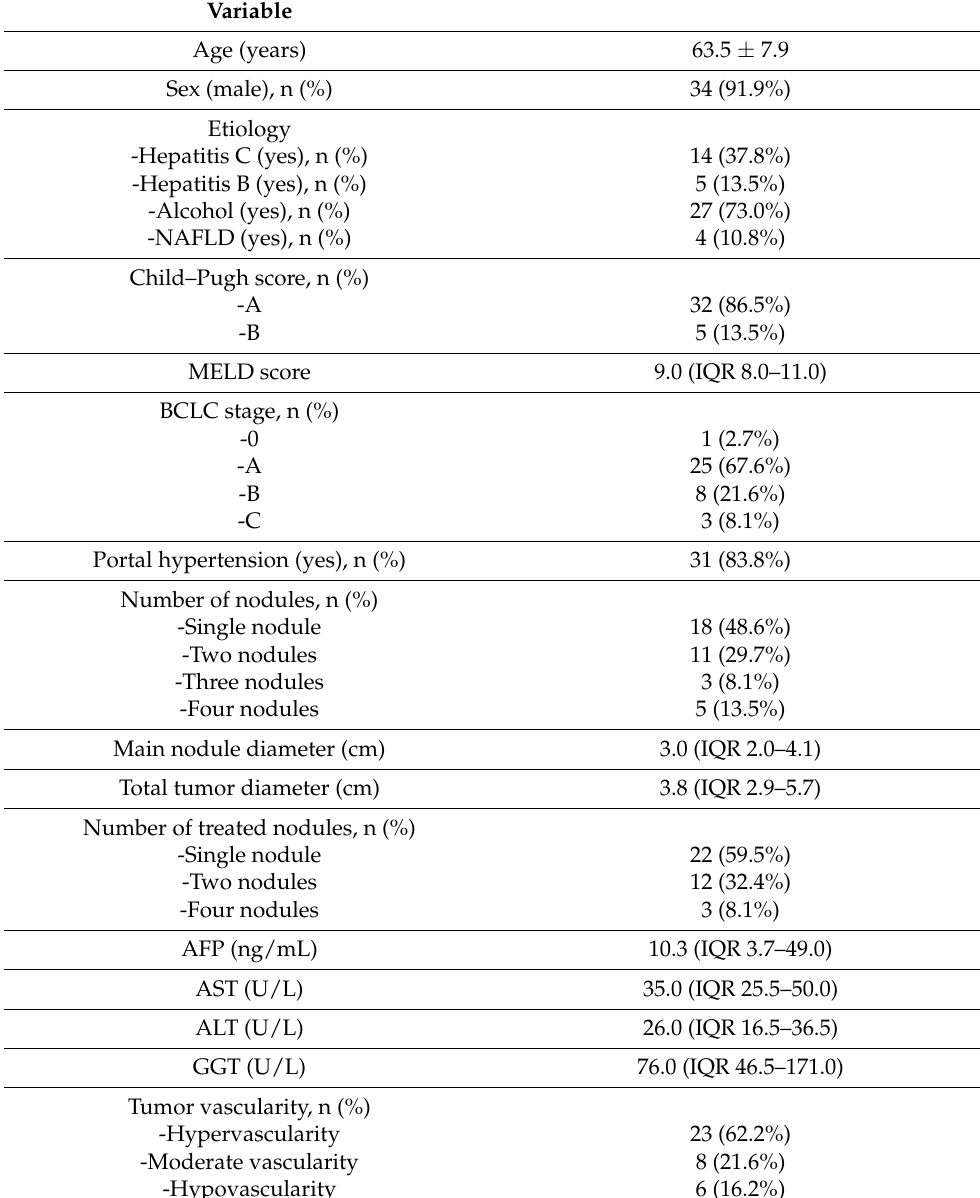
Table 1. Clinicopathological characteristics of 37 prospectively enrolled patients with hepatocellular carcinoma undergoing transarterial chemoembolization as a first-line therapy.